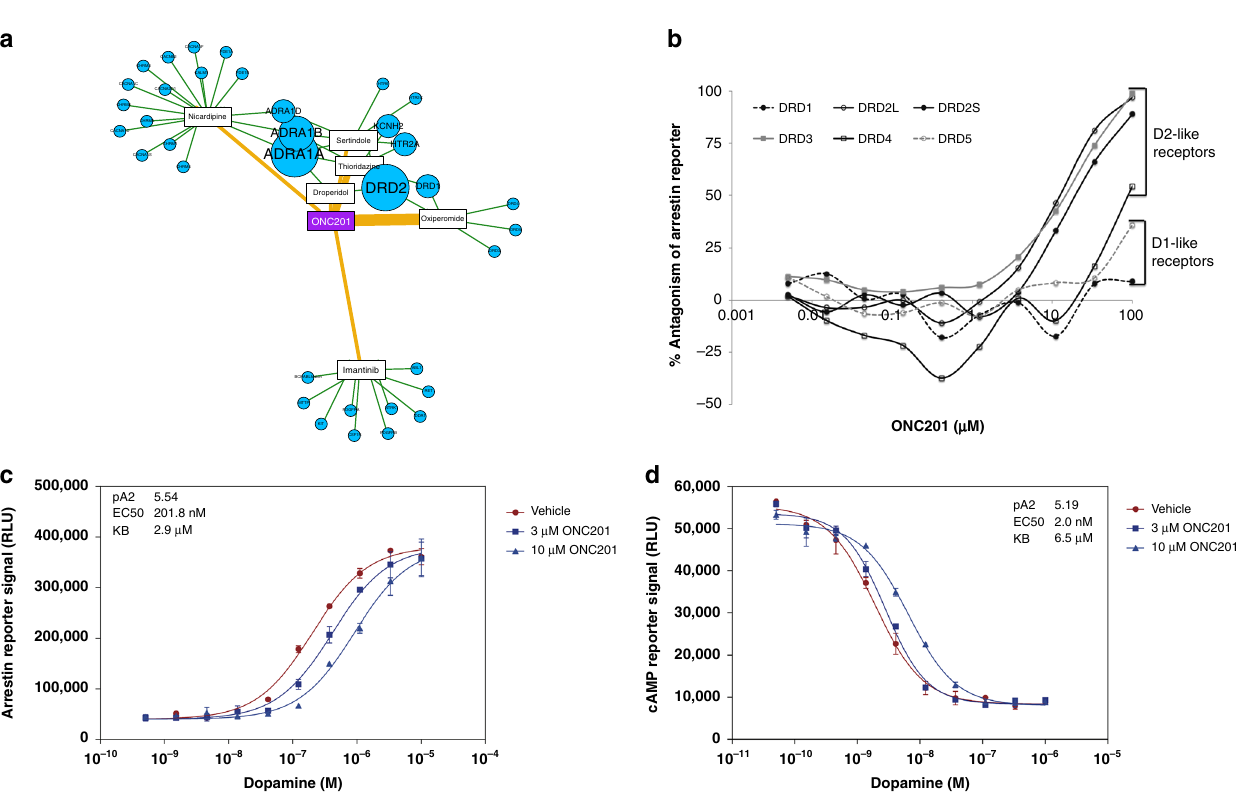
Fig. 5 ONC201 is a selective DRD2 antagonist. a BANDIT target predictions for ONC201. Connections between ONC201 and known drugs are weighted based on the likelihood ratio and predicted targets are sized based on the prediction strength. b Antagonism of ligand-stimulated dopamine receptors by ONC201. c Schild analysis of DRD2L antagonism by ONC201 using arrestin recruitment or d cAMP modulation reporters. Error bars represent 1 standard